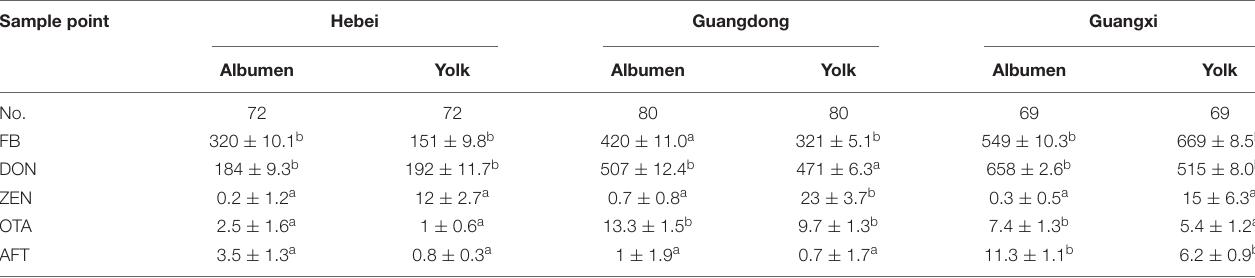
TABLE 3 | Detection of FB, DON, ZEN, OTA, and AFT in the yolk and albumen of breeder eggs. Sample point